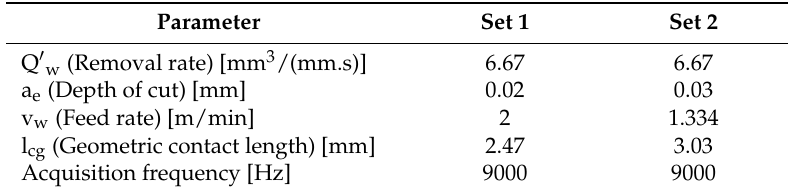
Table 1. Theoretical parameter Set 1 (S1) and Set 2 (S2).